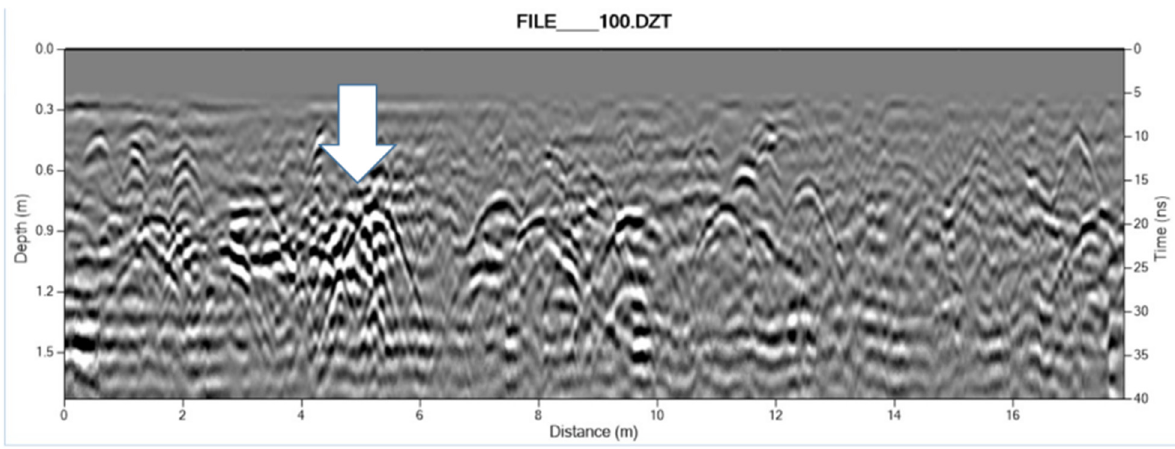
Figure 26. Newly identified by GPR survey, subsurface adobe features are adjacent to standing Castro Adobe wall.